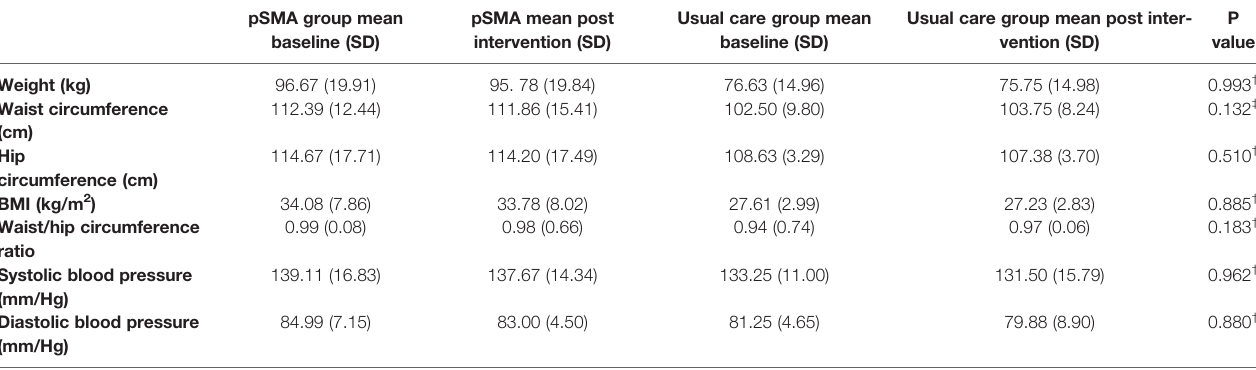
TABLE 5 | Anthropometric measures and blood pressure at baseline and 12 weeks.